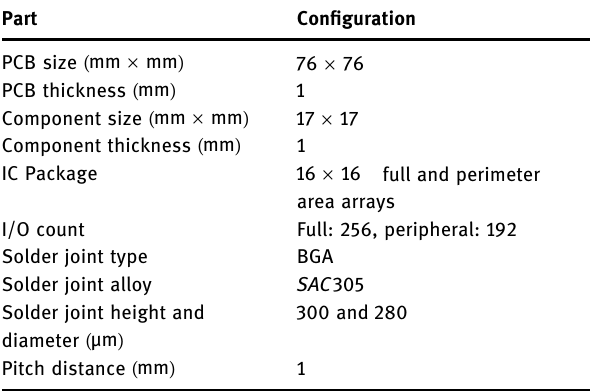
Table 1: Test con fi gurations details